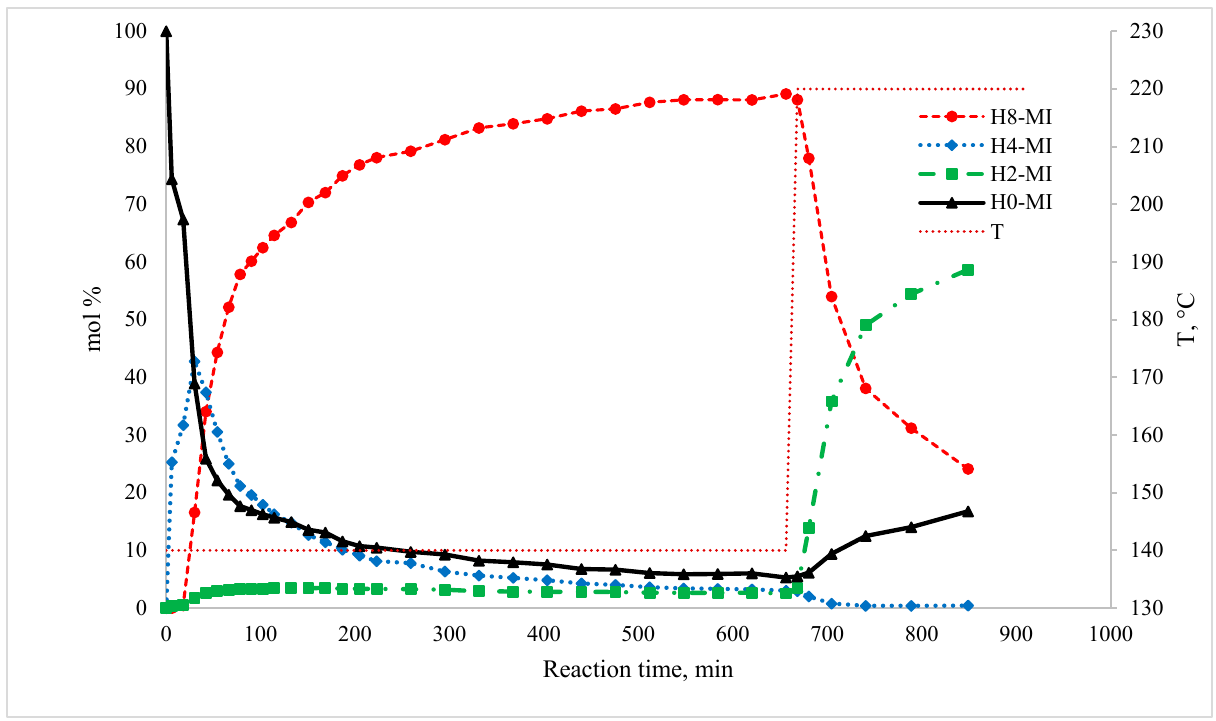
Figure 3. Plot of the typical reaction mixture composition with respect to contact time in H0-MI hydrogenation. Catalyst = 9.1% mass (12% Ni/SiO 2 ); P 0 mol/mol.